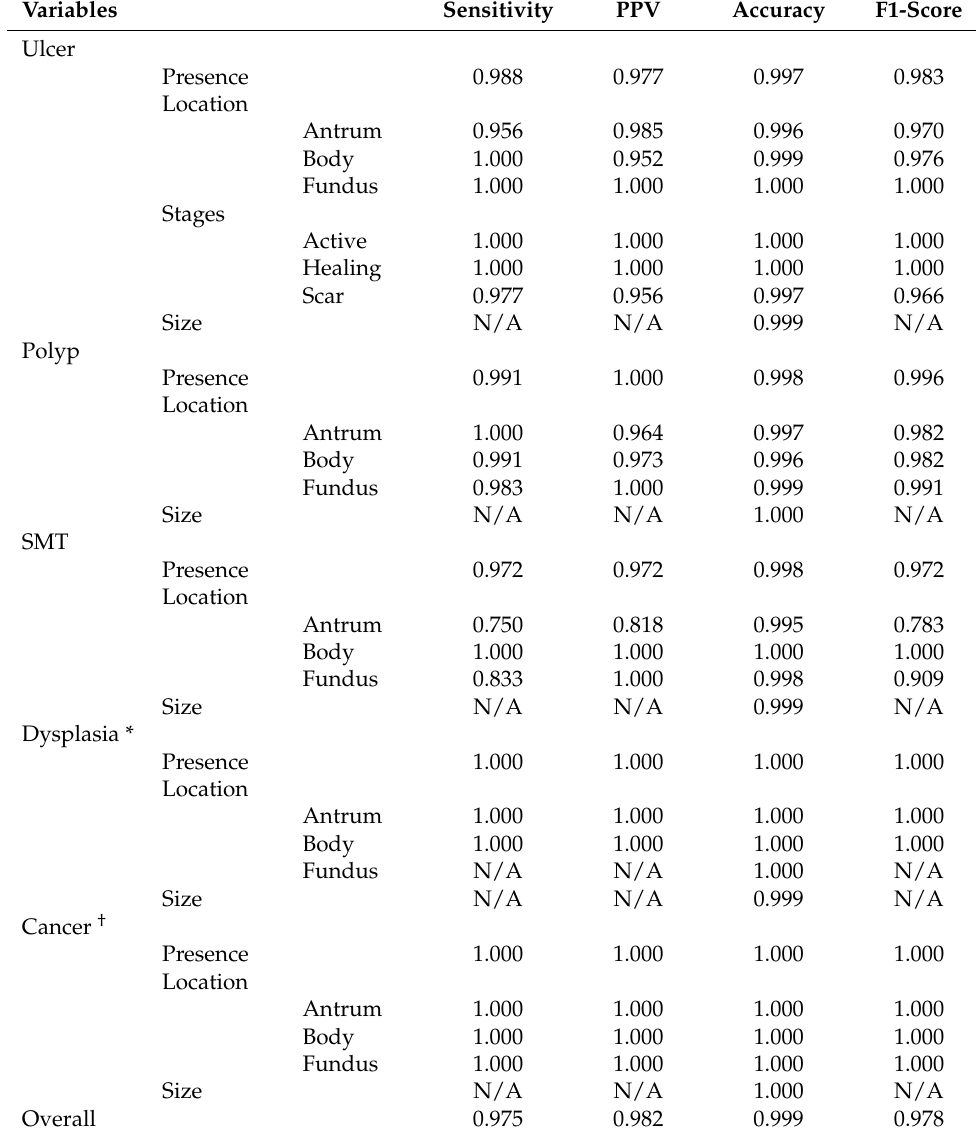
Table 3. Performance of information extraction for gastric ulcers, polypoid lesions, and neoplastic diseases using the NLP